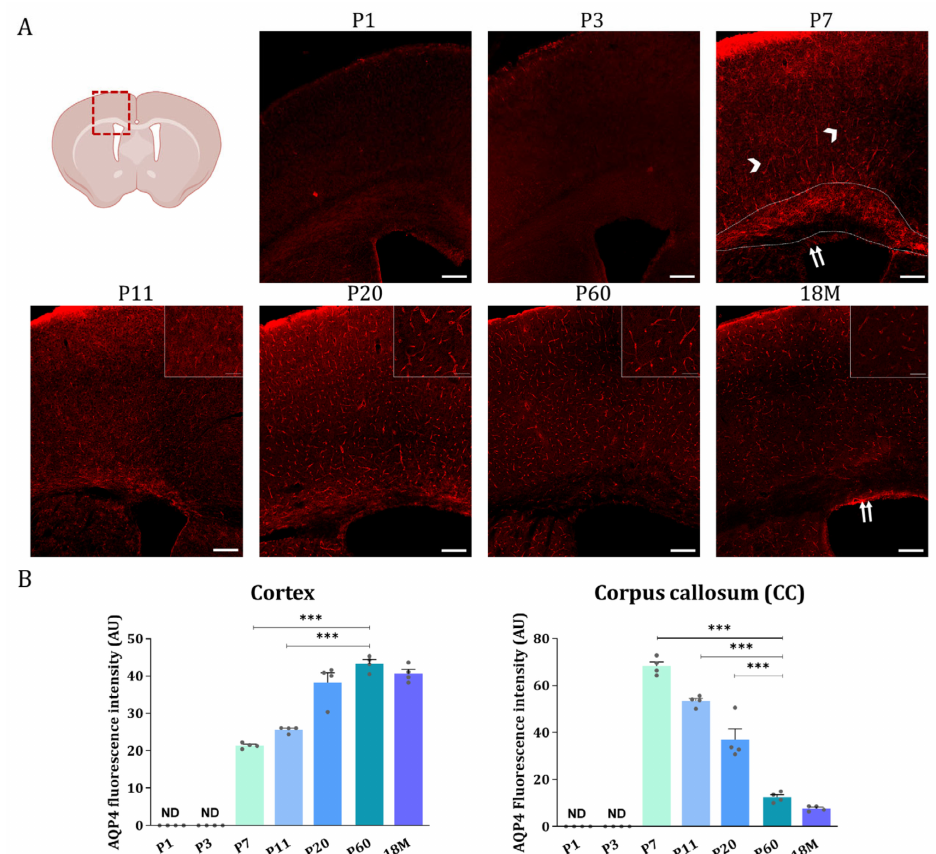
Figure 4. AQP4 immunofluorescence signal shifts from the corpus callosum at early developmental stages to the cortical vasculature in the adult brain. ( A ) Fluorescence Immunohistochemistry showing spatiotemporal AQP4 protein distribution (red) in corpus callosum and cortex from coronal sections at P1, P3, P7, P11, P20, P60 and 18 M. Scale bar = 150 µ m. Detailed images of the cortical vasculature were added at P11, P20, P60, and 18M. Inset scale bar = 30 µ m. ( B ) Quantification of AQP4 signal was measured by optical density and the intensity levels obtained were compared between different developmental groups in both cortex and corpus callosum regions. Data represent the mean ± SEM from n = 4 analyzed for each age. Statistically significative differences between mean values were assessed by ANOVA test with post hoc TUKEY multiple comparison test. (*** p < 0.001). Illustration of the coronal brain section was designed with BioRender (Accessed on 22 November 2022, https: